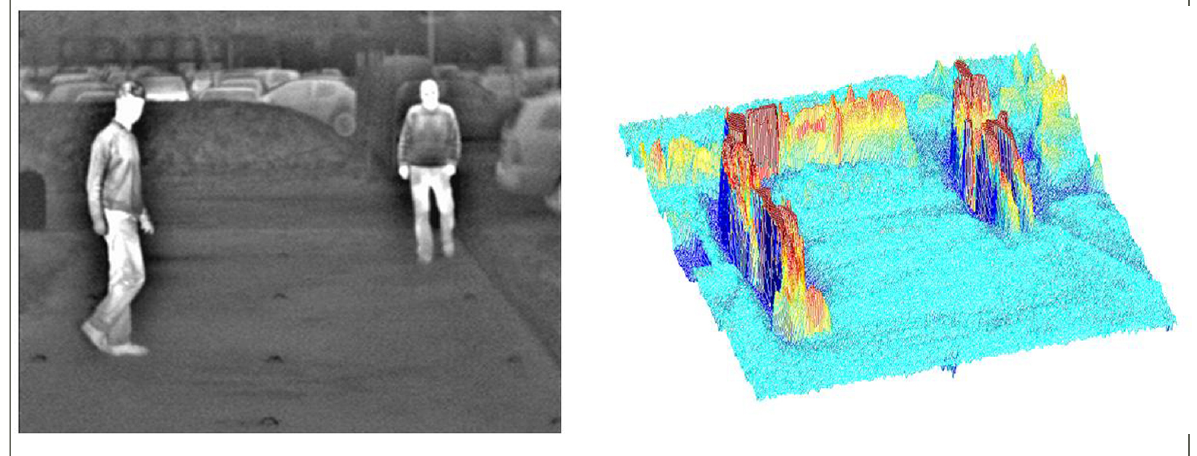
Figure 4 Energy field due to the image: (a) original image and (b) intensity energy functional with inverted sign, to obtain a more effective graphical